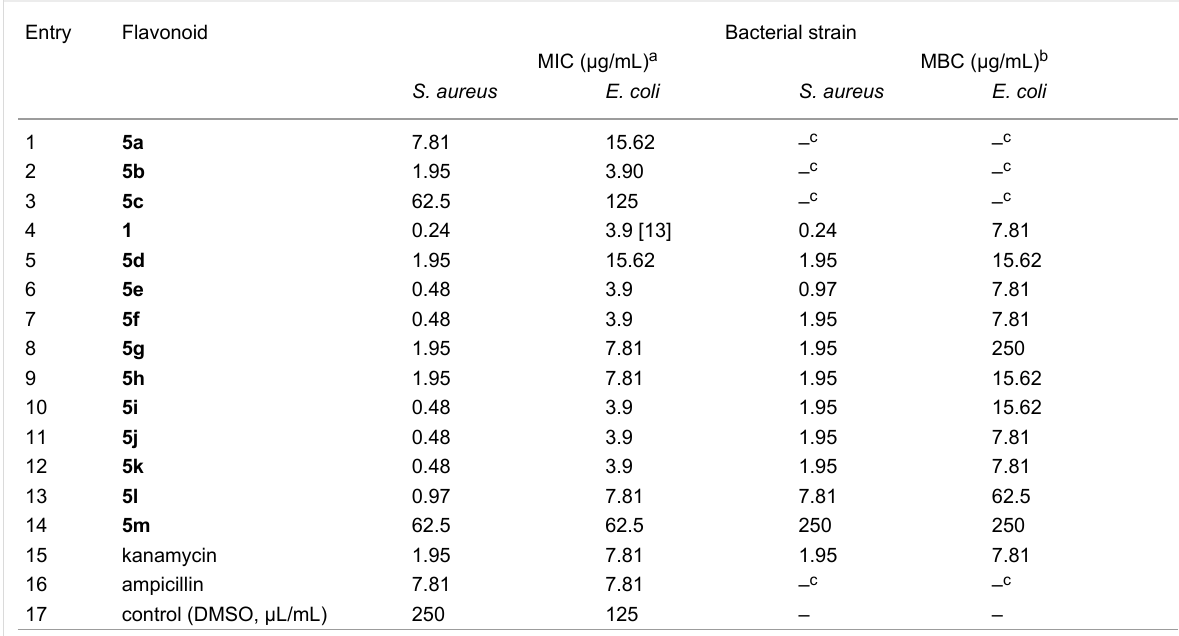
Table 5: Minimum inhibitory concentrations and minimum bactericidal concentrations of flavonoids 5a – m against Staphylococcus aureus and Escherichia coli . Entry